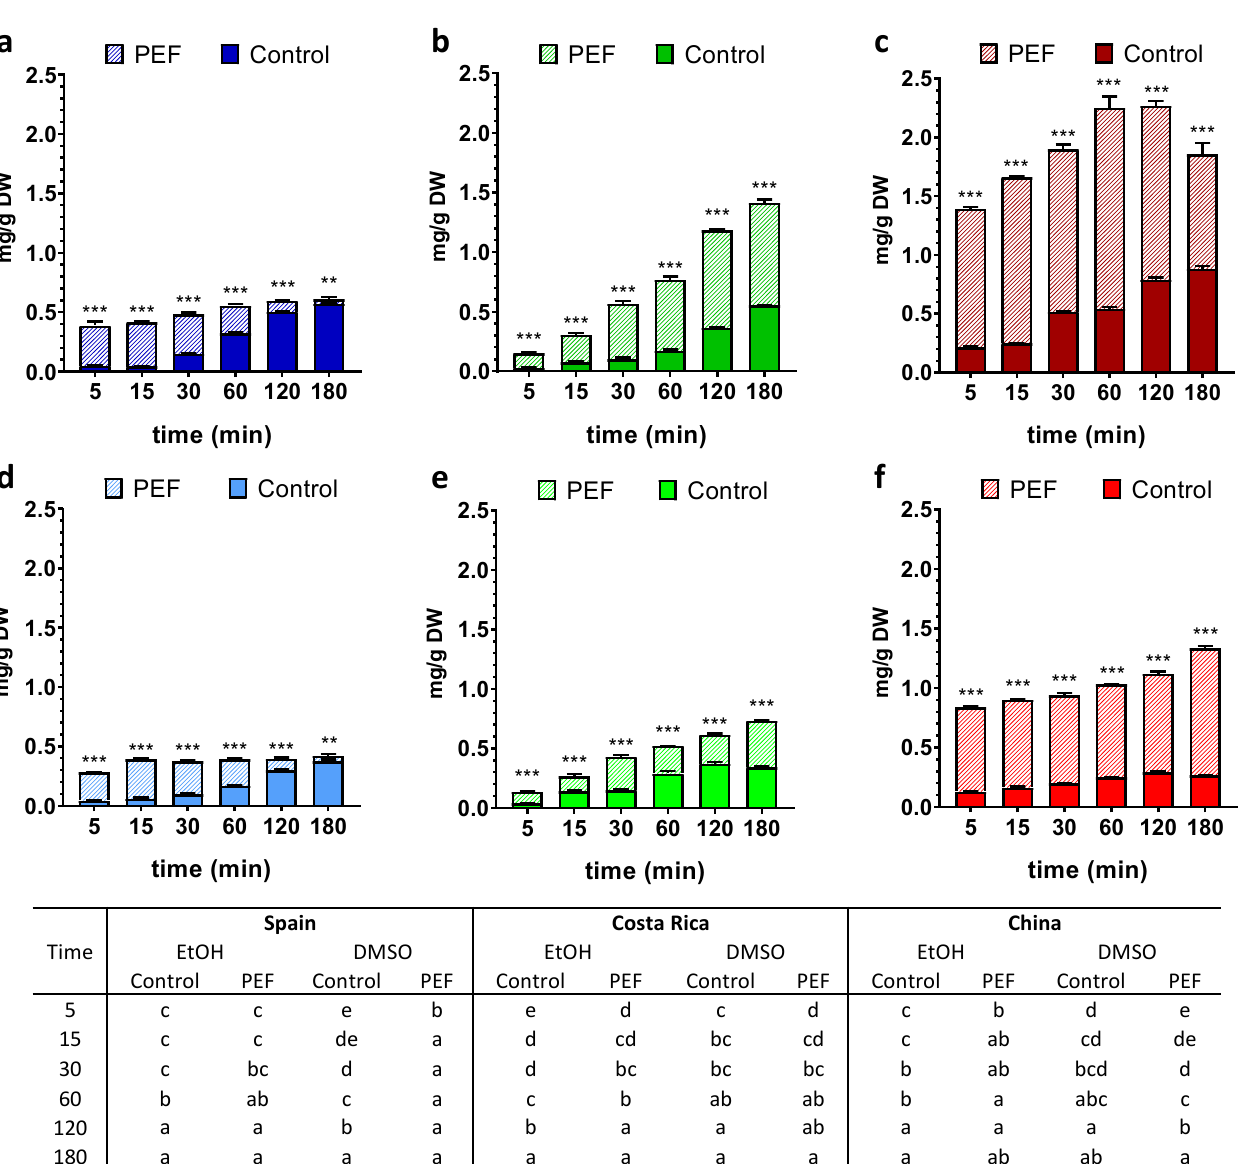
Figure 3. Chlorophyll a content of Spirulina extracts with PEF treatment or without PEF treatment (Control) for ethanol:water ( a – c ) and DMSO:water ( d – f ) solvent from Spirulina cultivated in different geographical regions (blue: Spain, green: Costa Rica, red: China). Statistical differences related to the PEF treatment are represented by asterisks (*). Statistical differences related to the extraction time are represented by different lower-case letters in the table. ** = p < 0.01; *** = p < 0.001. Similarly, the highest C b contents (1.57 ± 0.09 and 1.14 ± 0.02 mg/g DM) were obtained for PEF-treated Spirulina from China in the extract of EtOH and DMSO, respectively. However, in this case, PEF pre-treatment did not produce an interesting improvement in C b extraction (Figure 4).